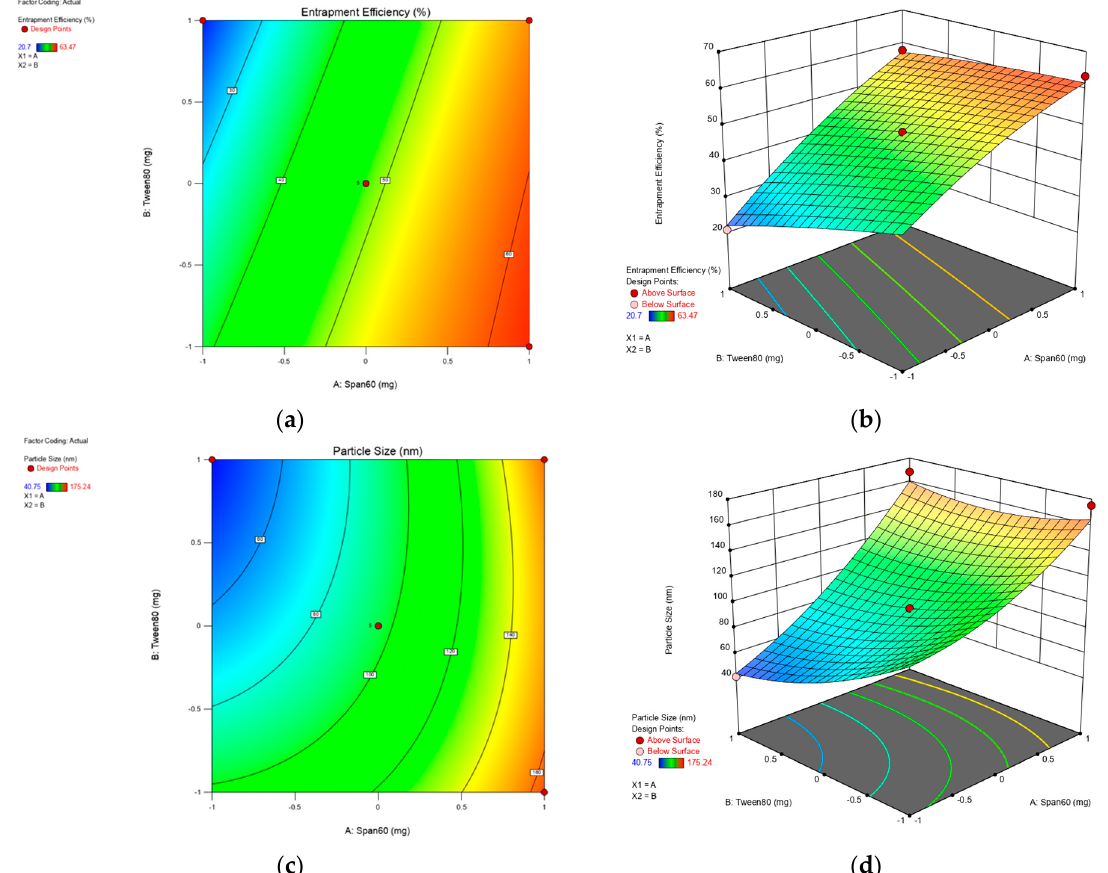
Figure 1. Contour and 3D-surface plots for the effect of Span 60 and Tween 80 concentrations on the following for zolmitriptan spanlastics formulations: entrapment efficiency ( a , b );and particle size ( c , d ) .